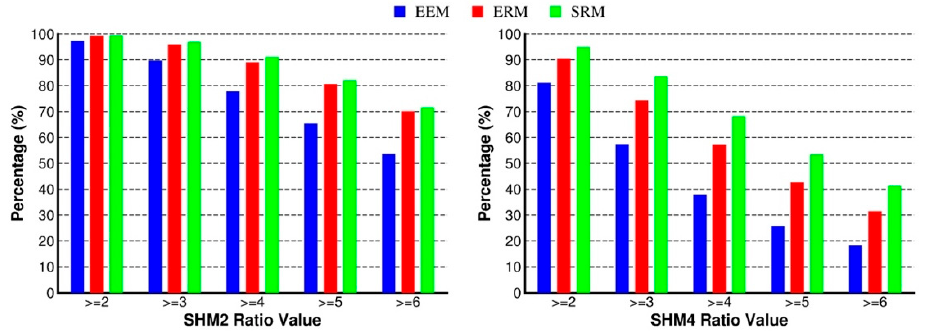
Figure 16. Success rate of WL ambiguity resolution for schemes of EEM, ERM and SRM.